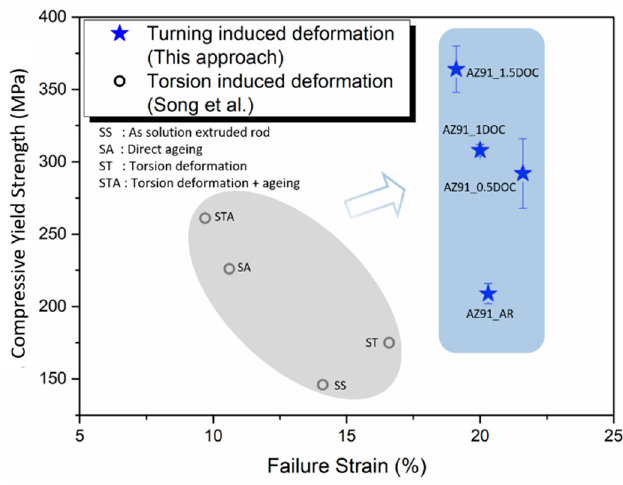
Figure 6. Comparison between turning-induced and torsion-induced deformation.